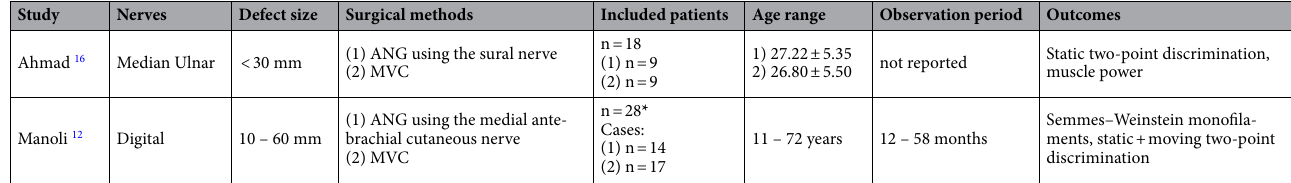
Table 3. Extracted details of the included clinical studies. *: Note that the number of cases was higher than the number of patients because three patients in the MVC group each underwent reconstruction of two digital nerve defects with